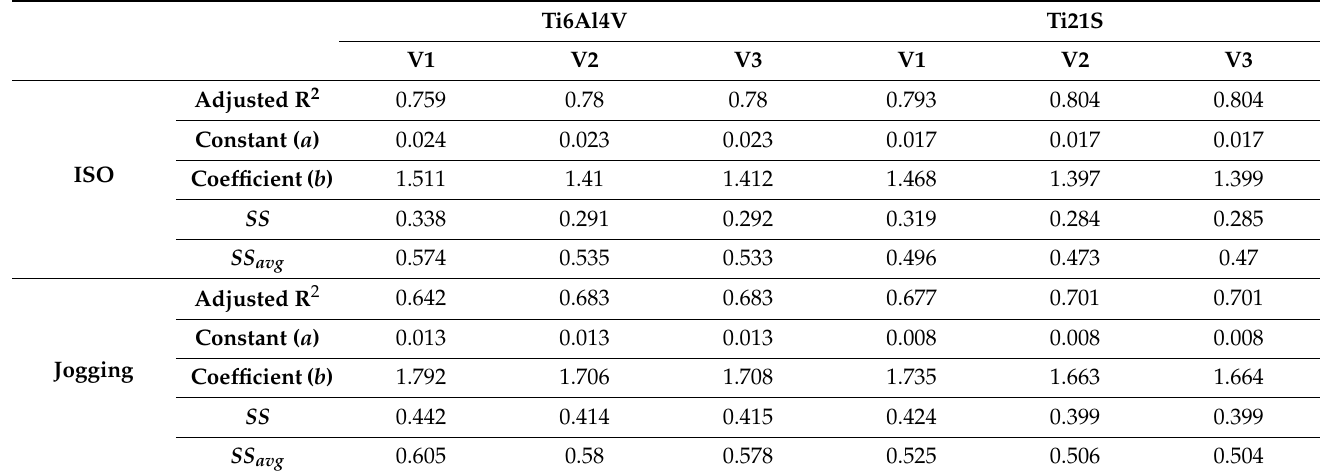
Table 5. Results for